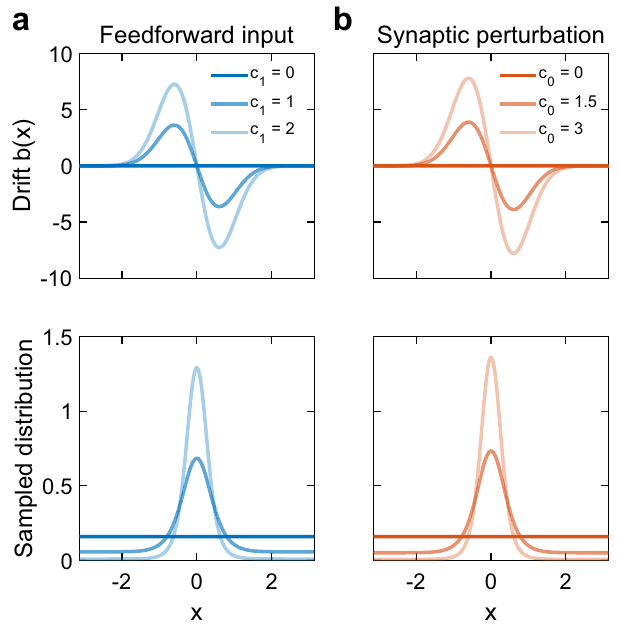
Fig. 7 | Drift term related to feedforward input and synaptic perturbations. a Drift term (upper panel) and sampled distribution (lower panel) when the neural fi eldmodelreceivesafeedforwardinputwithvaryingcontrastlevels c (upper panel) and sampled distribution (lower panel) when the neural fi eld model receives synaptic weight perturbation with varying strengths c 0